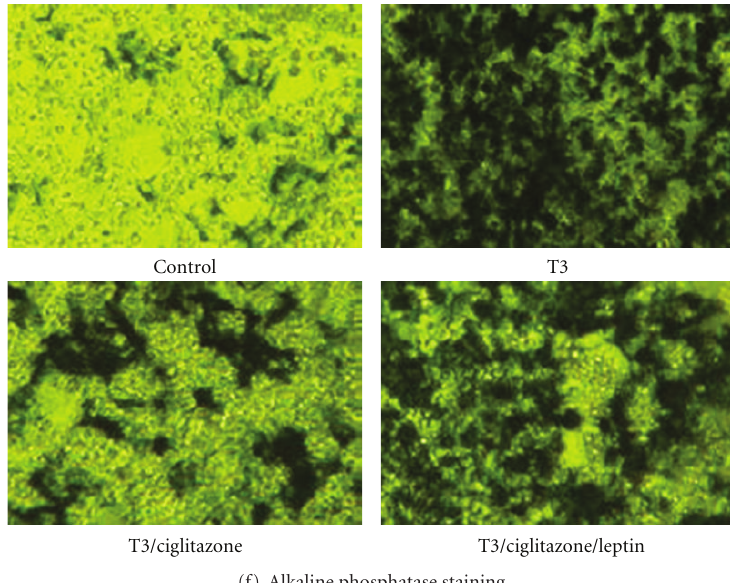
Figure 1: Leptin suppresses the e ff ects of PPAR γ on chondrogenic di ff erentiation and chondrocyte hypertrophy in growth plate chondrocytes. ((a), (b)) Quantitative real-time RT-PCR analysis of Col2a1 (a) and aggrecan (b) mRNA expression in chondrocytes treated with ciglitazone and/or leptin for 5 days. ∗ P < 0 . 05 versus the expression in control cells. ∗∗ P < 0 . 05 versus the expression in the cells treated with ciglitazone alone. (c) Alcian blue staining of growth plate chondrocytes in monolayer cultures after 5 days of treatment with ciglitazone and/or leptin. ((d), (e)) Expression of Col10a1 mRNA expression (d) and alkaline phosphatase activity (e) of growth plate chondrocytes treated with ciglitazone and/or leptin for 5 days. ∗ P < 0 . 05 versus the cells treated with T3 alone. ∗∗ P < 0 . 05 versus the chondrocytes treated with both T3 and ciglitazone. (f) Alkaline phosphatase staining of chondrocytes cultured in monolayer and treated with ciglitazone and/or leptin for 5